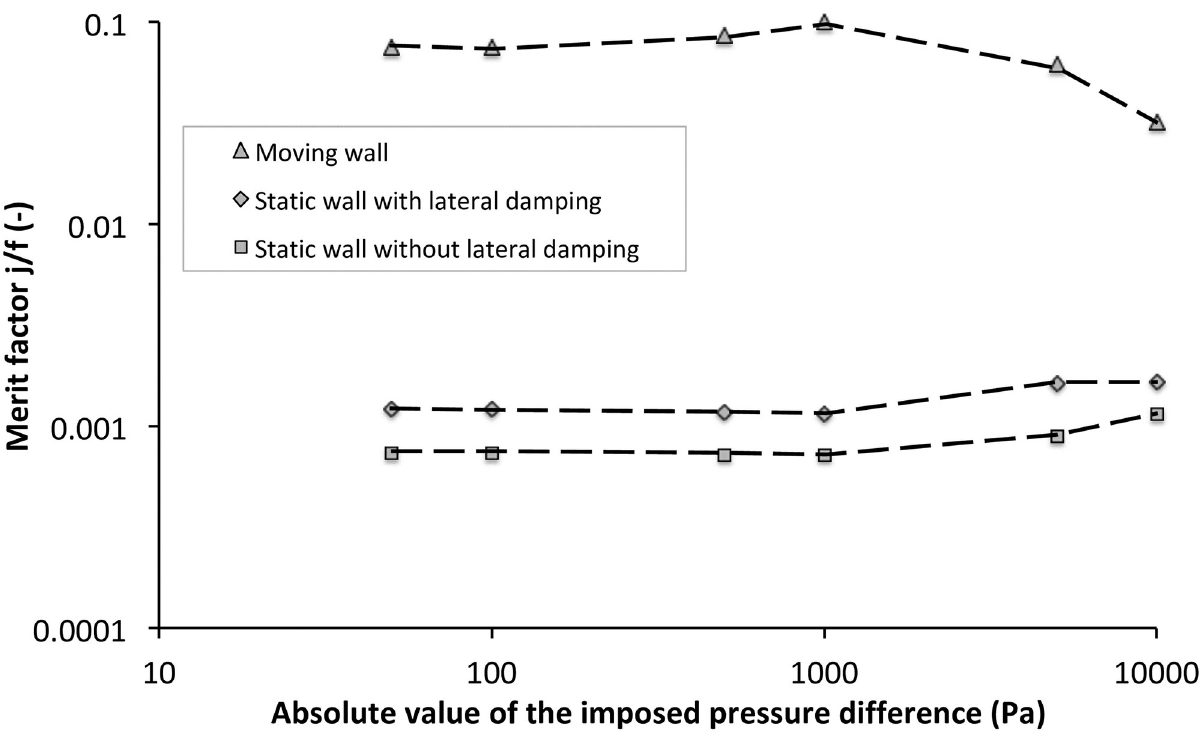
Fig 10. Performances of the dynamic corrugated heat exchanger. Merit factor for corrugated moving, static with and without lateral damping (log- log scales). Different imposed negative pressure differences for relative amplitude of A = 89% and f r = 50 Hz .